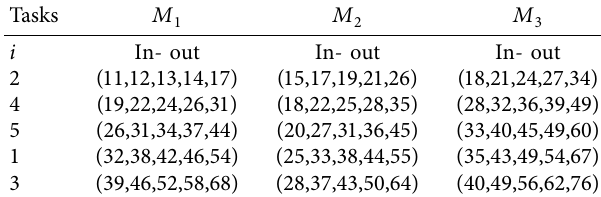
Table 9: The in-out flow for S